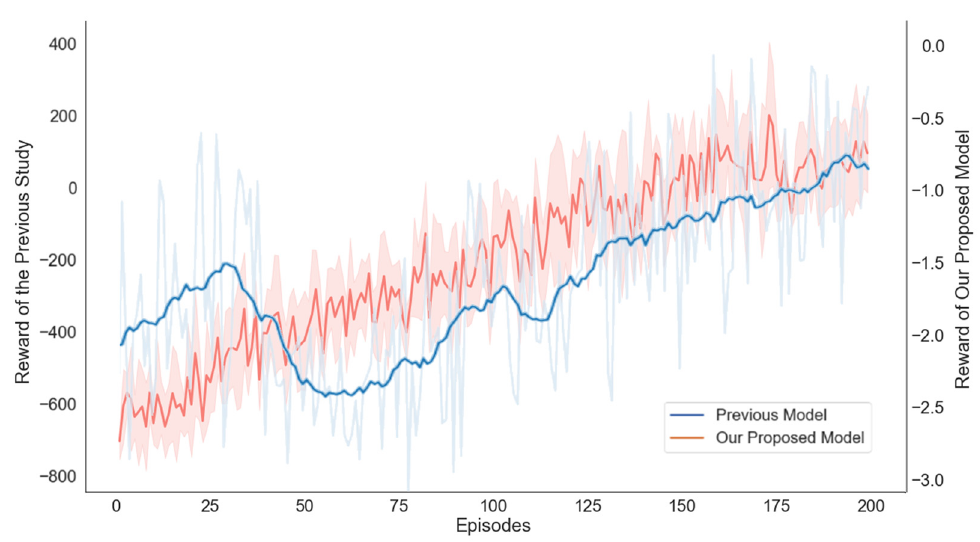
Figure 11. The analysis of average reward values for behavioral control by episode.